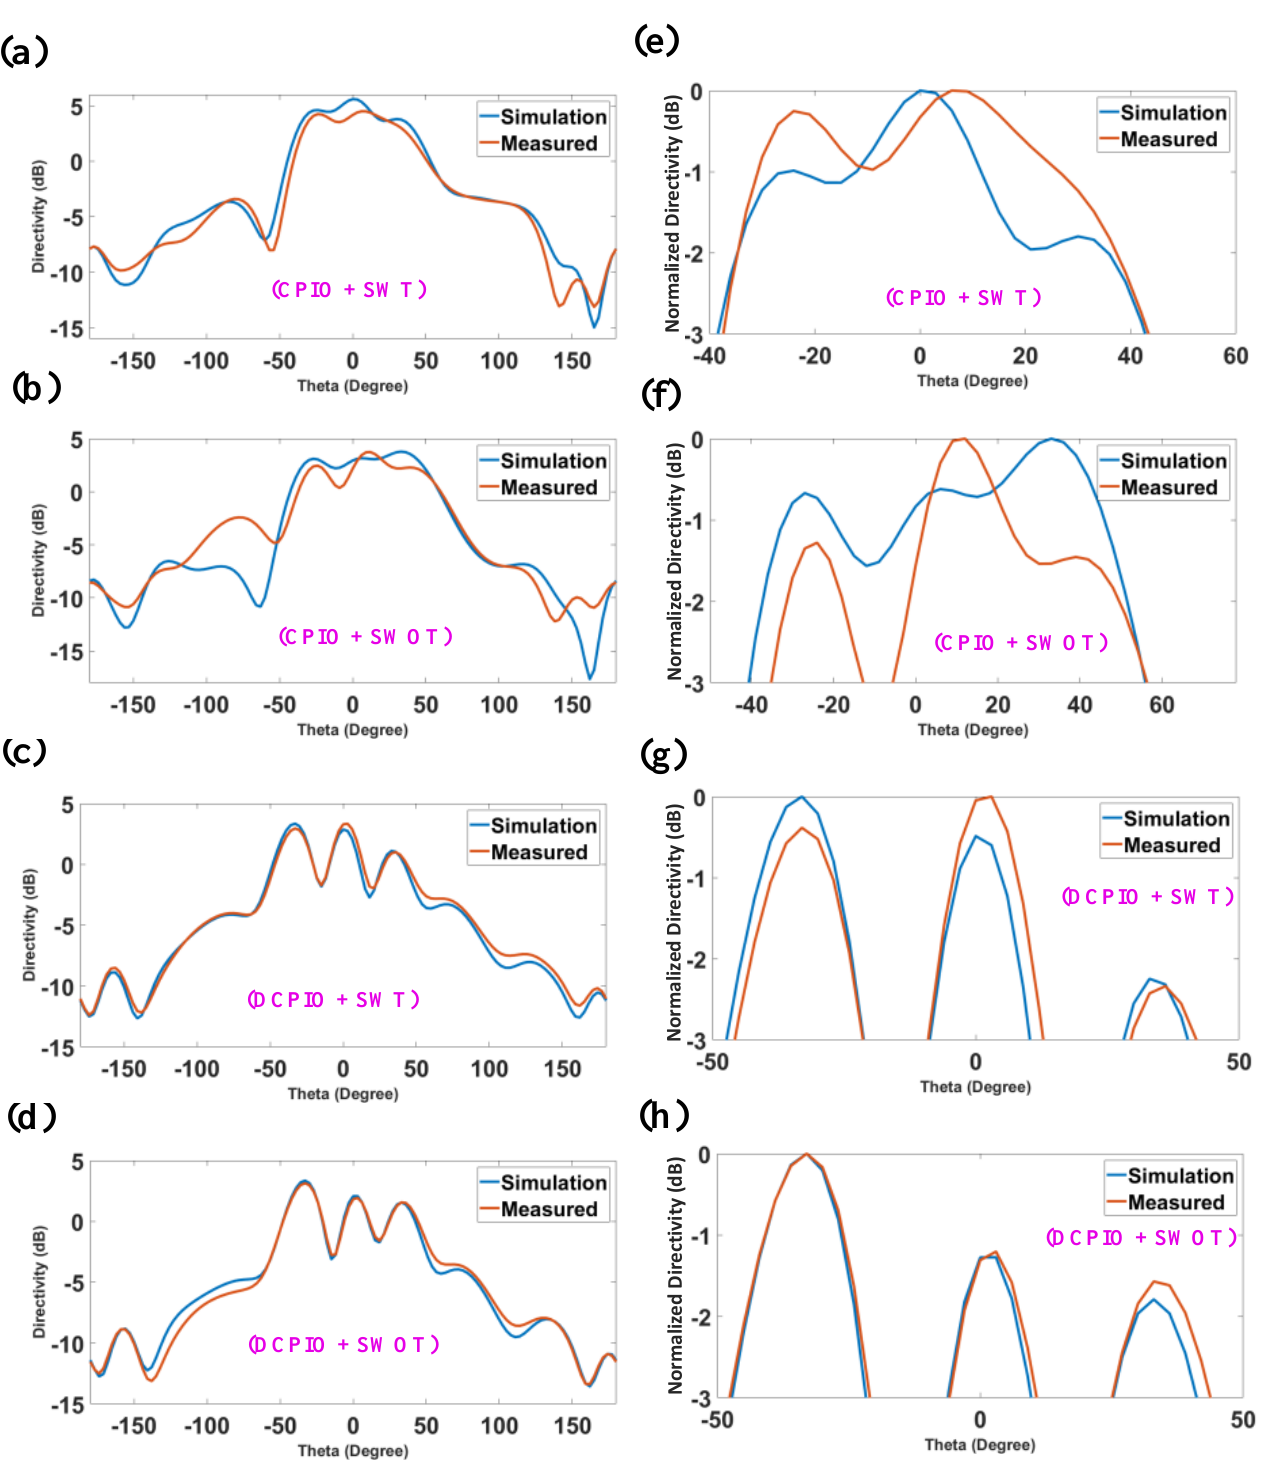
Figure 9. Maximum directivity and the normalized directivity for all of the modes are, respectively, 5.59 dB with 81 ◦ , 3.77 dB with 93 ◦ , 3.35 dB with 21 ◦ , 18 ◦ , 13 ◦ and 3.34 dB with 23 ◦ , 17 ◦ , 14 ◦